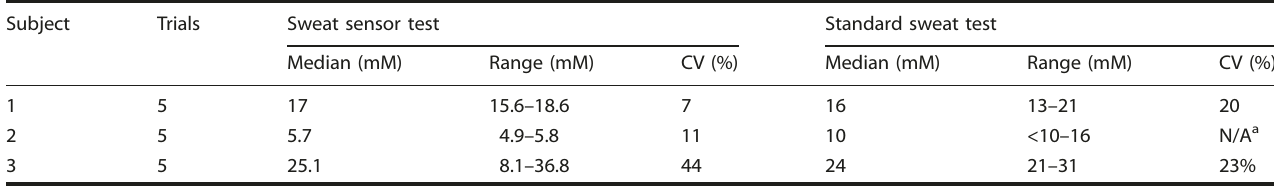
Table 2. Variation of sweat chloride concentration measured by a wearable sensor during walking at 1.8 m s − 1 and from a standard sweat test following pilocarpine